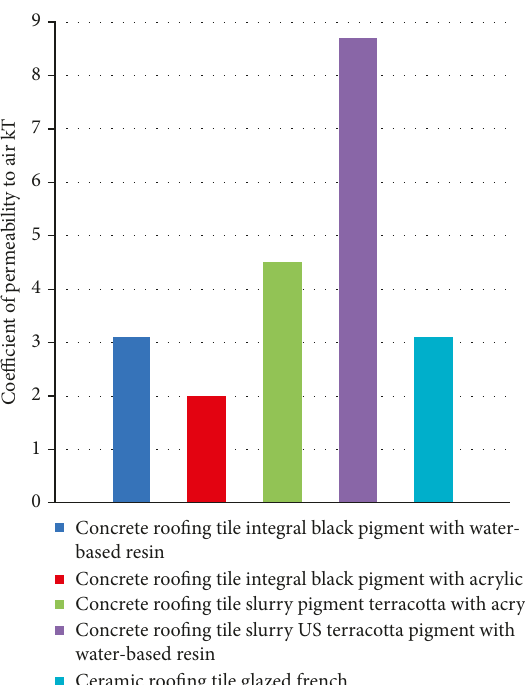
Concrete roofing tile integral black pigment with acrylic Concrete roofing tile slurry pigment terracotta with acrylic